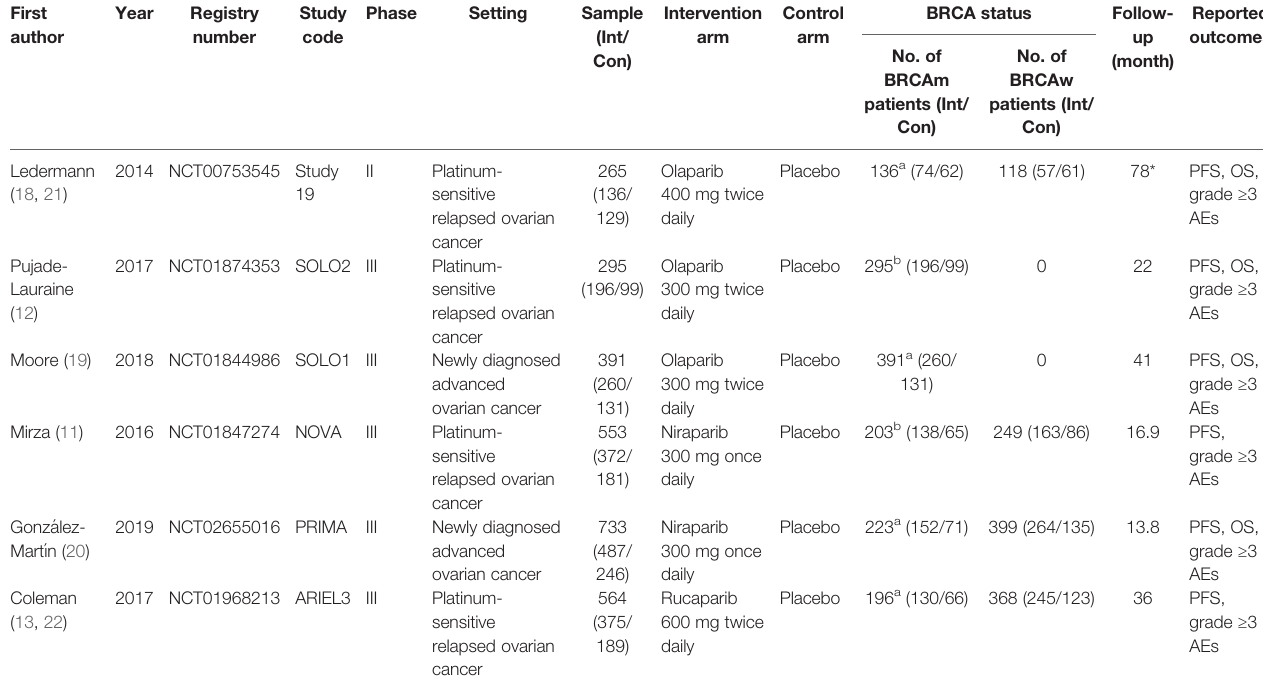
TABLE 1 | Baseline characteristics of included studies.